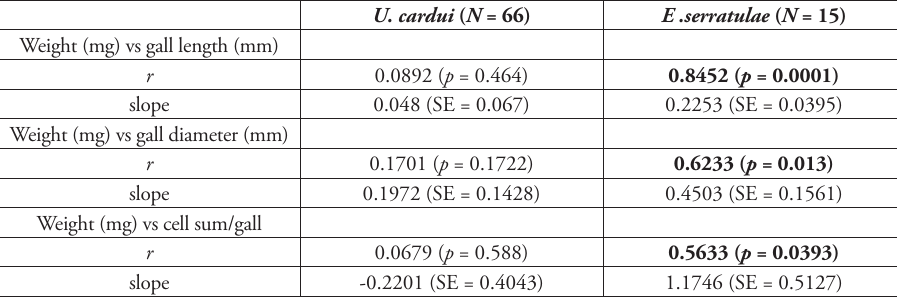
Table 2. Correlation of body weight of unparasitized U. cardui and E. serratulae larvae within U. cardui mummies with gall